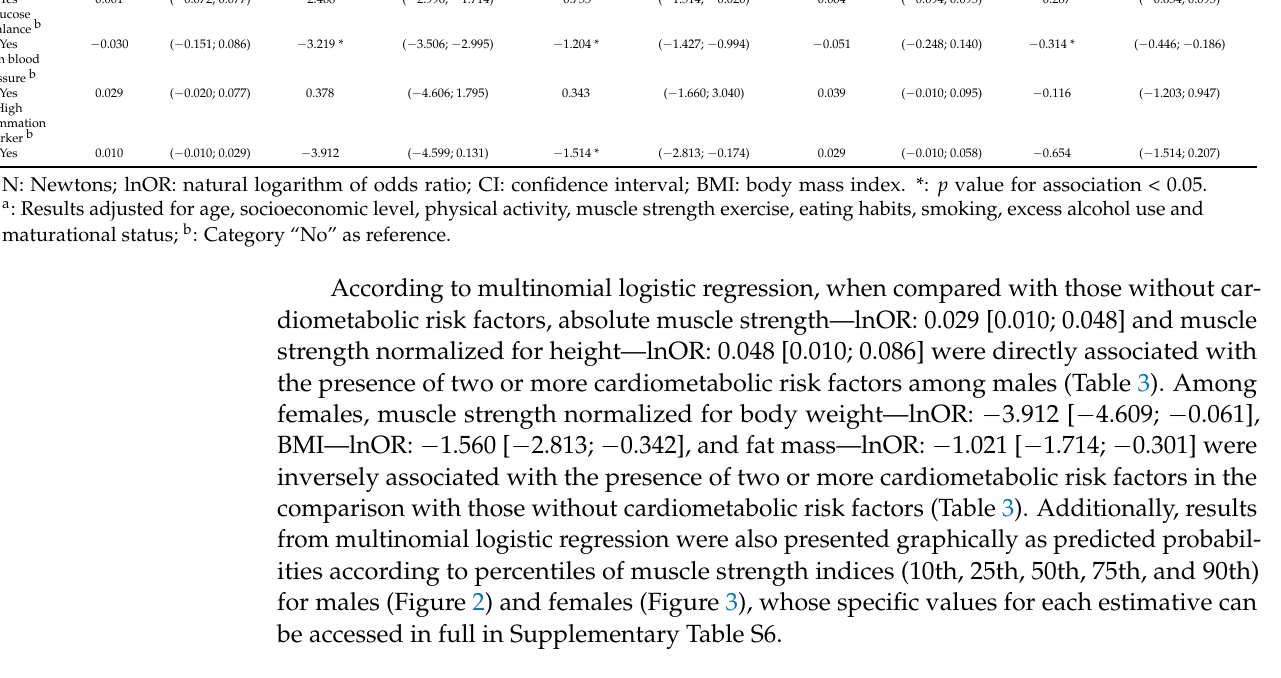
Table 3. Adjusted a association from multinomial logistic regression between muscle strength and number of cardiometabolic risk factors according to